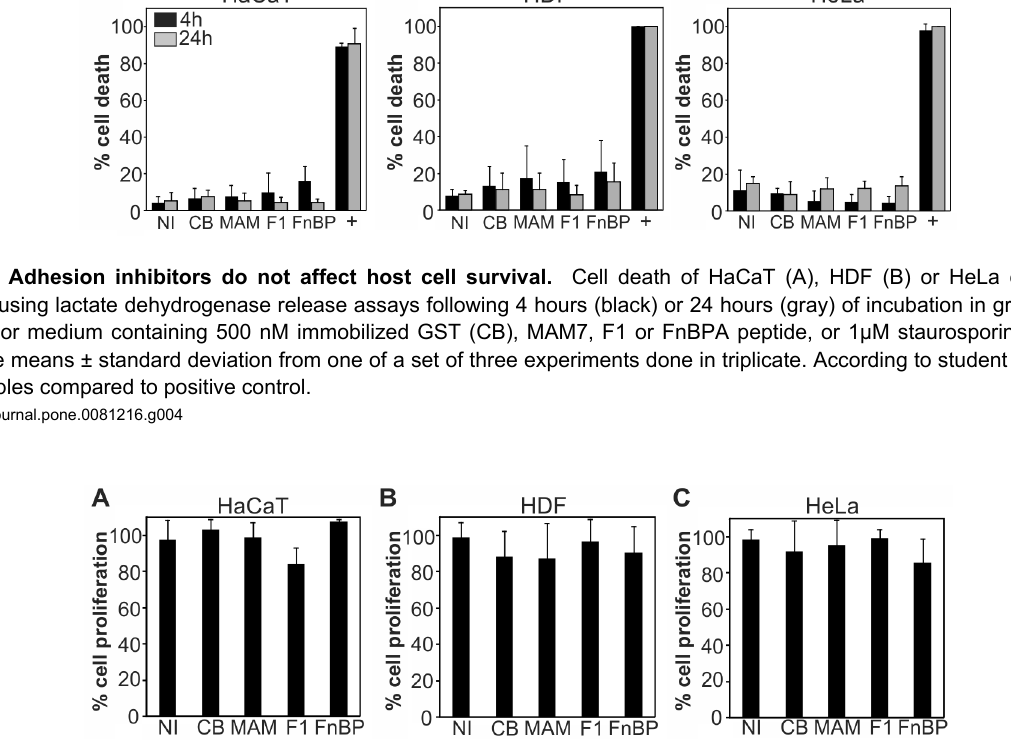
Figure 5. Adhesion inhibitors do not affect host cell proliferation. Proliferation of HaCaT (A), HDF (B) or HeLa cells (C) was measured using a CyQUANT NF proliferation assay in medium alone (NI) or medium containing 500 nM immobilized GST (CB), MAM7, F1 or FnBPA peptides. Results are means ± standard deviation from one of a set of three experiments done in triplicate. doi: